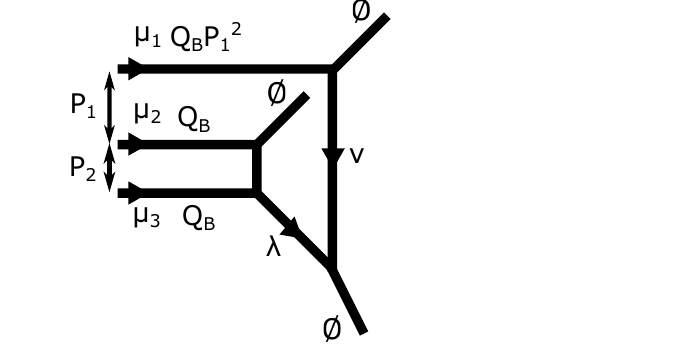
Figure 50. Assignment of Young diagrams and Kähler parameters for one of the four diagrams